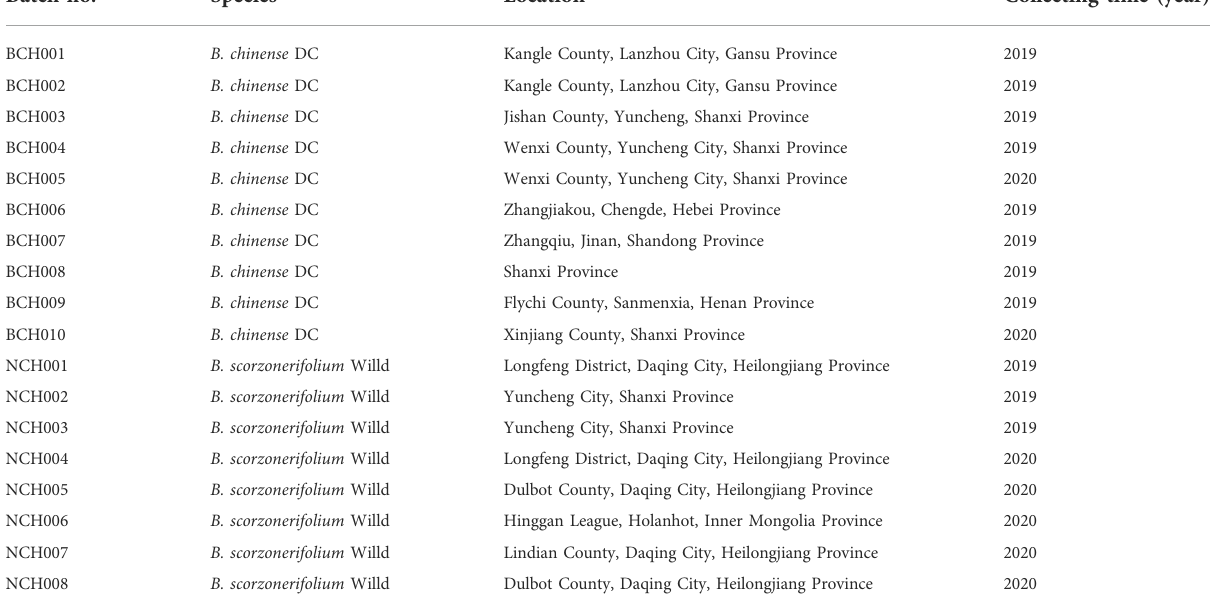
TABLE 1 Information of collected BR samples. Batch